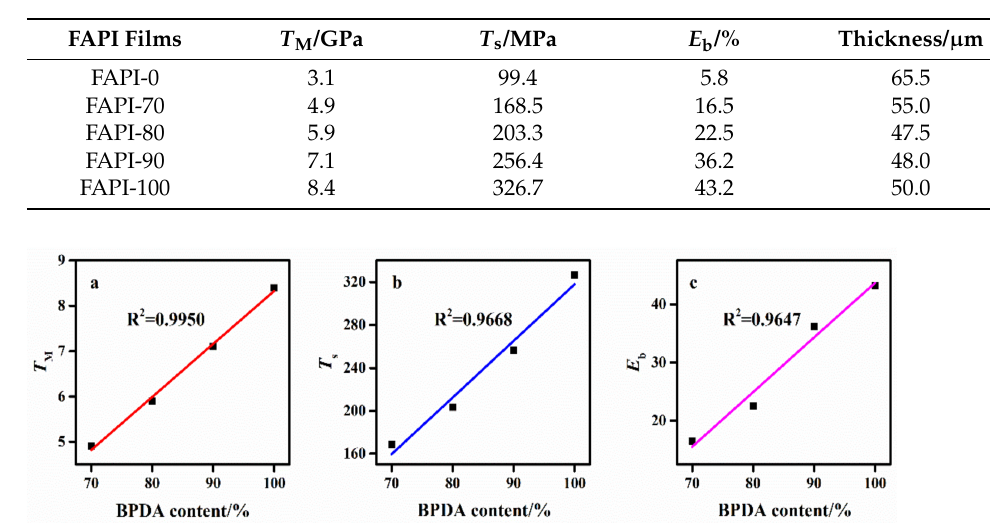
Figure 3. Relationship between mechanical properties and the biphenyl group content in polymer backbone.